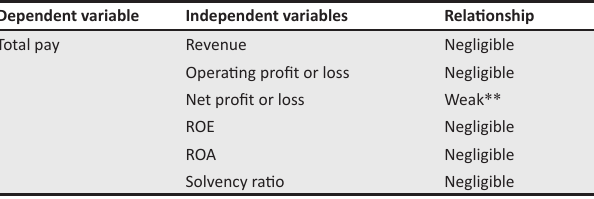
TABLE 4: Summary of relationship between executive pay and company